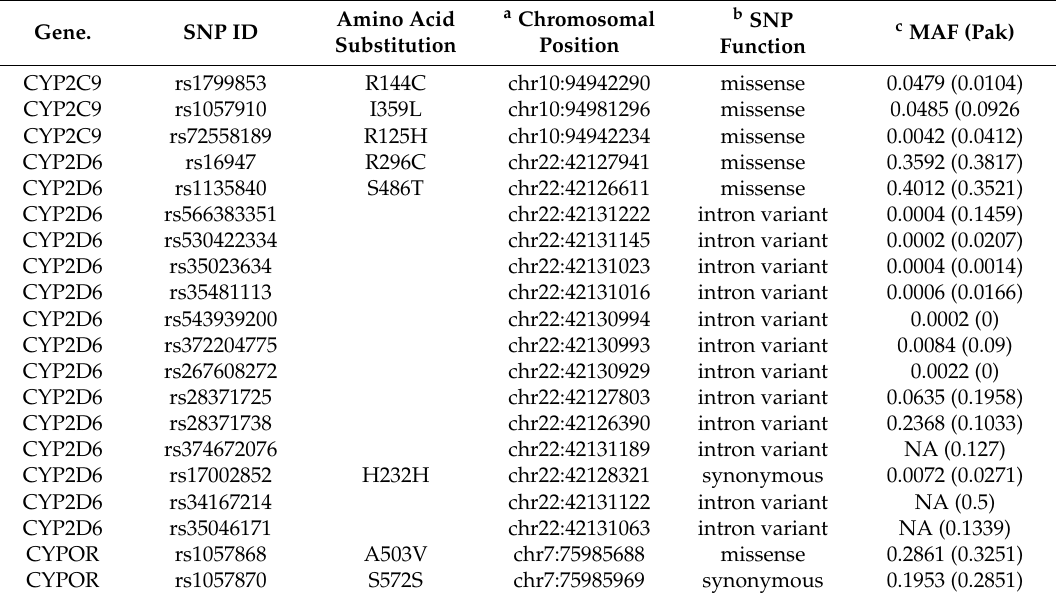
Table 1. Basic characteristics of studied genotyped